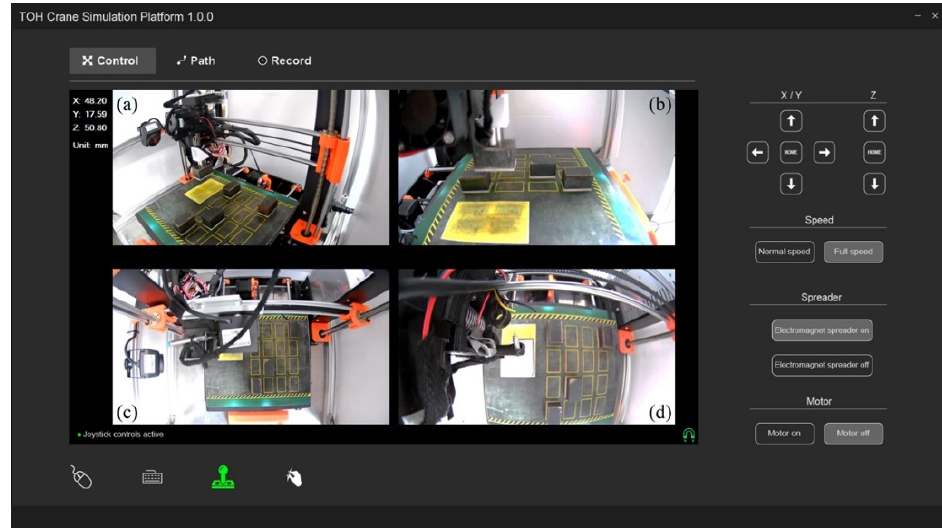
Figure 2. Screen capture of the controller software. ( a ) Global view. ( b ) Conventional cabin view. ( c ) Bird view. ( d ) Top view.